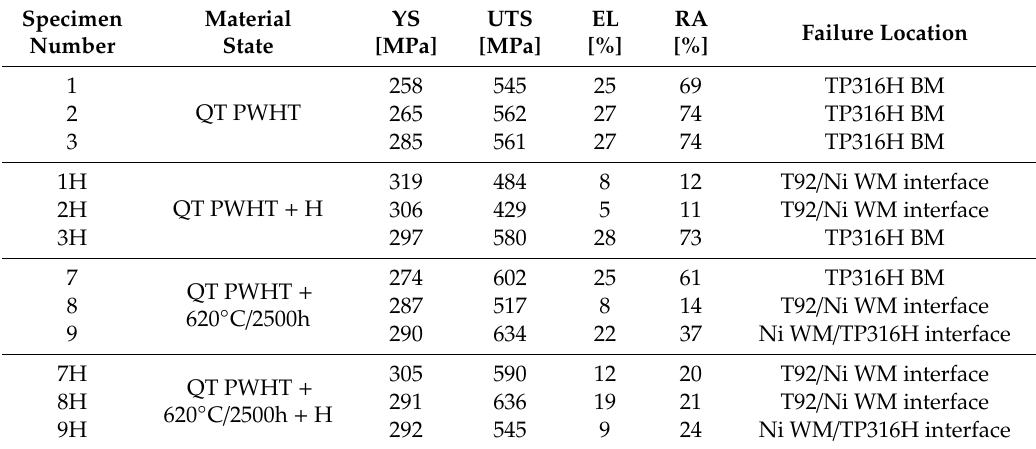
Table 2. Room-temperature tensile properties and failure locations of T92 / T316H dissimilar weldments with Ni-base weld metal for individual material states.